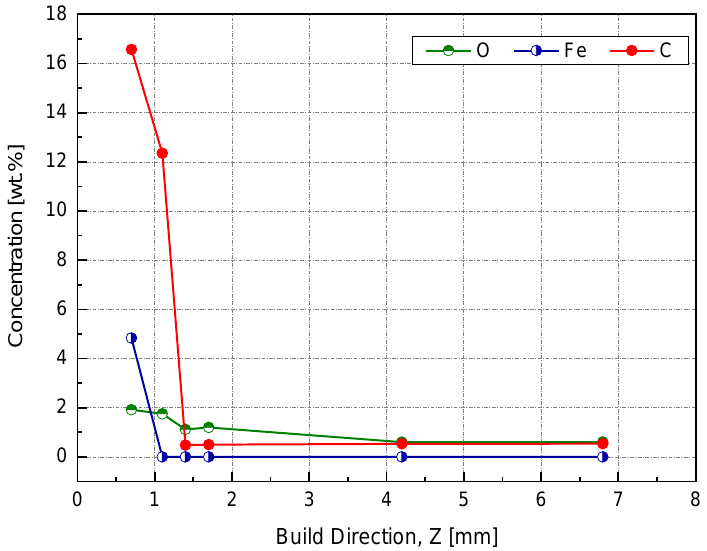
Figure 17. Weight percent of impurities using the XPS peak area along the building direction (Z). The starting point was at 0.4 mm, which corresponded to 0.7 mm of the actual Z, since the difference between the sample heights before and after wire cutting was 0.3 mm. At this point, we noticed a high Fe content, around 5 wt %, which was above the solubility limit of Fe in Cu, and was attributed to the rapid solidification [33]. The transition from